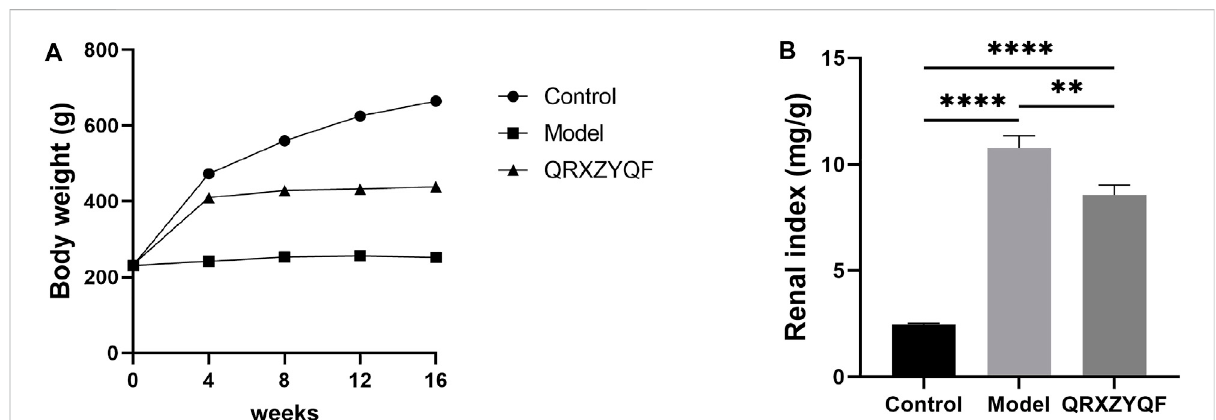
FIGURE 2 QRXZYQF treatment raised body weight and reduced renal index in diabetic kidney disease (DKD) rats. (A) Changes of body weight in different groups since the start of the gavage intervention; (B) Comparisons of renal index among different groups, renal index = kidney weight (mg)/body weight